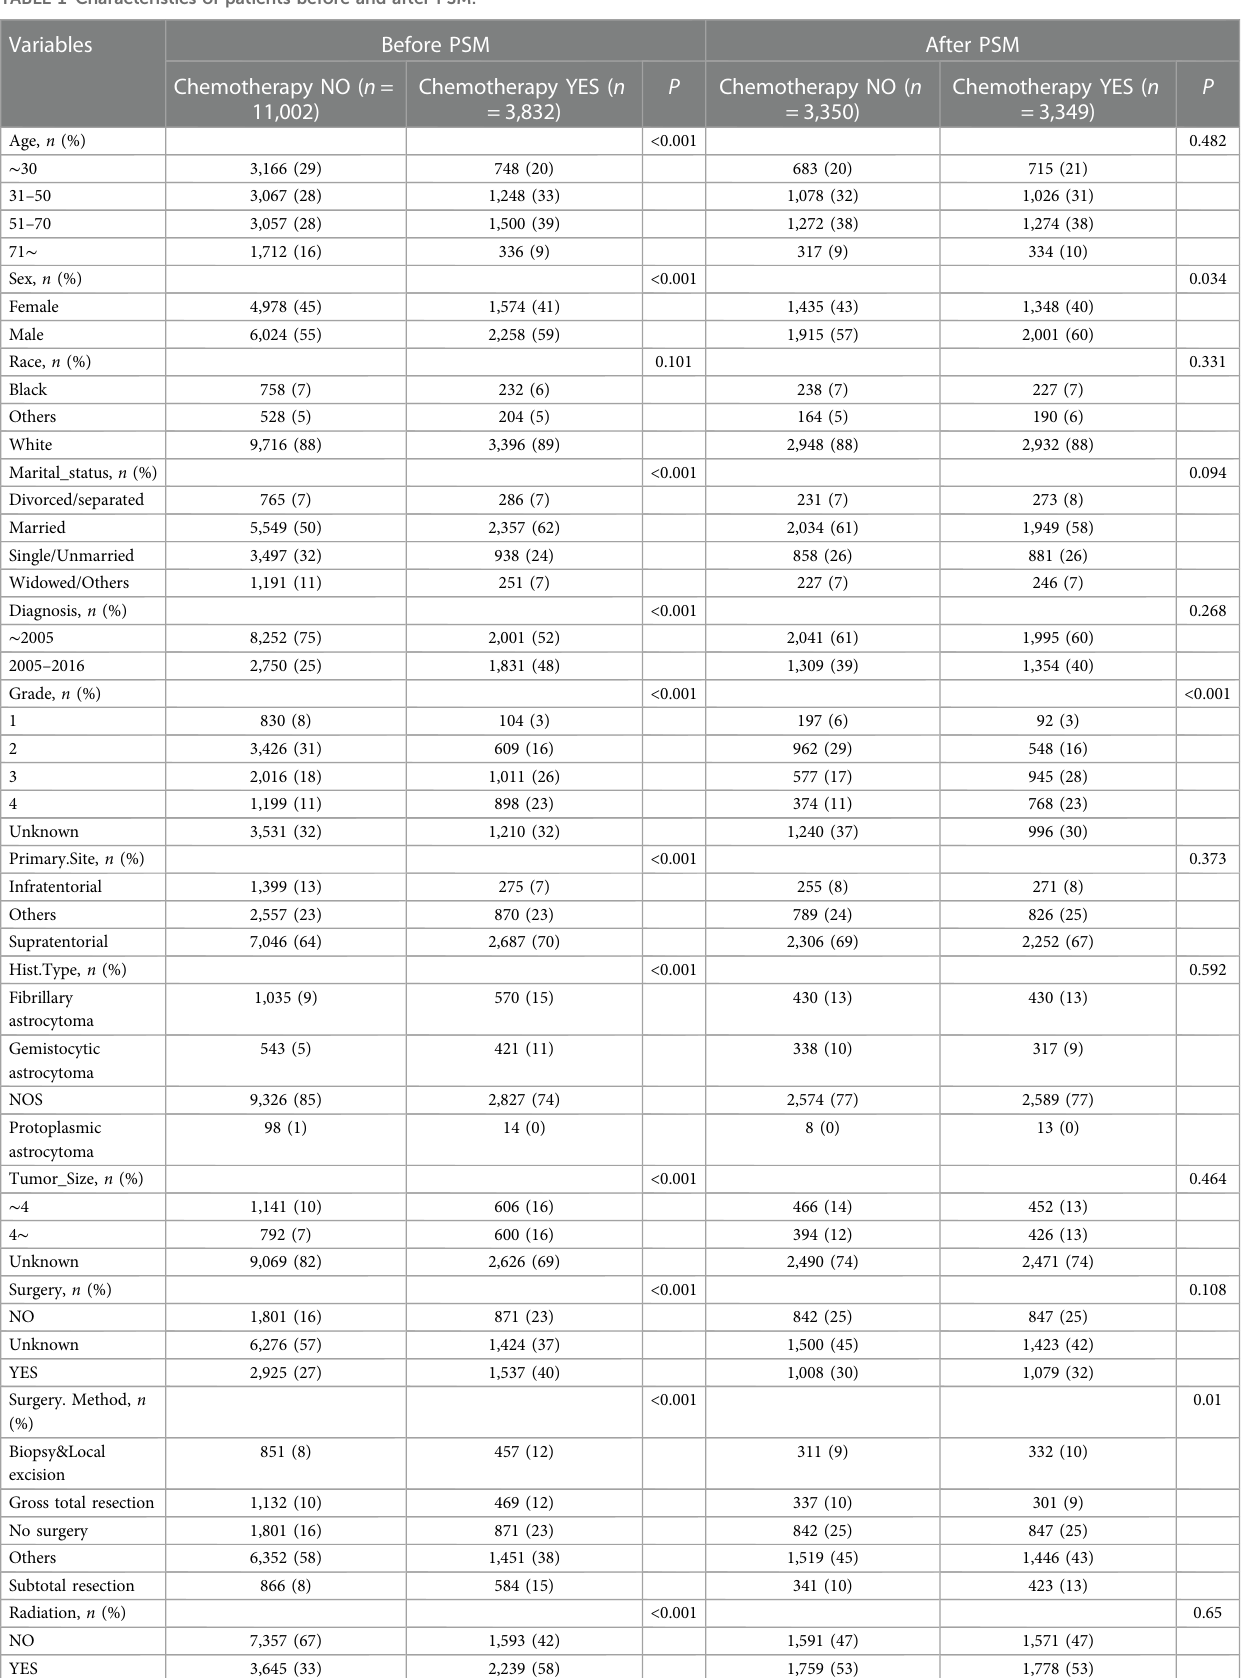
TABLE 1 Characteristics of patients before and after PSM.